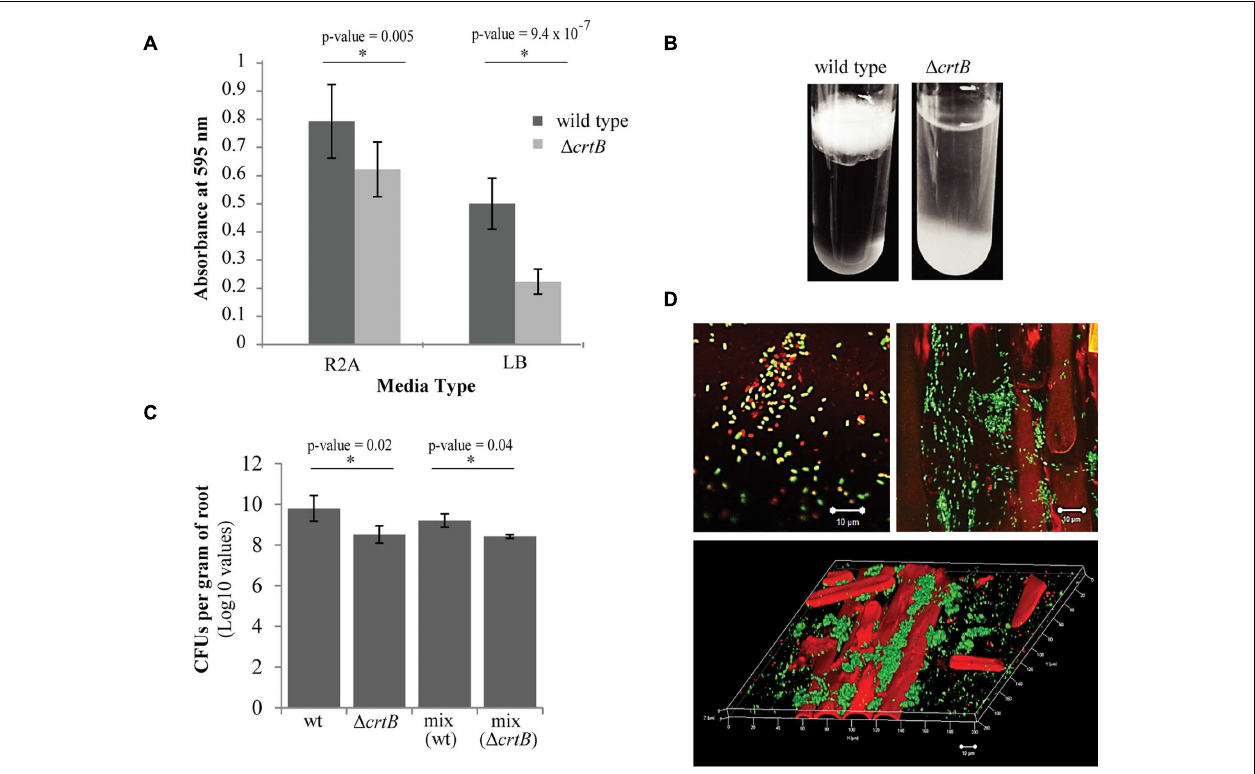
FIGURE 6 | Loss of carotenoids affects biofilm formation and root colonization. (A) Comparison of biofilm formation between wild type Pantoea sp. YR343 and the (cid:49) crtB mutant in plastic 96-well plates measured by the crystal violet assay (B) Pellicle formation assay performed in SOBG medium in glass test tubes. Wild type Pantoea sp. YR343 forms pellicles on top of the liquid medium, while the (cid:49) crtB mutant settles to the bottom of the tube. (C) Wheat root colonization assay by wild type Pantoea sp. YR343 and (cid:49) crtB is described as the Log10 value of colony forming units (CFUs) per gram of root material. (D) Images of wheat roots treated with YR343-GFP and (cid:49) crtB for 1 week and stained with Syto61. Top left image shows a group of motile cells outside of the plant. Green represents the wild type population, while red represents the (cid:49) crtB mutant population. Top right image shows a wheat root (visualized using autofluorescence in the red channel) colonized predominantly by wild typeYR343-GFP (green). Bottom image shows a three-dimensional view of a colonized wheat